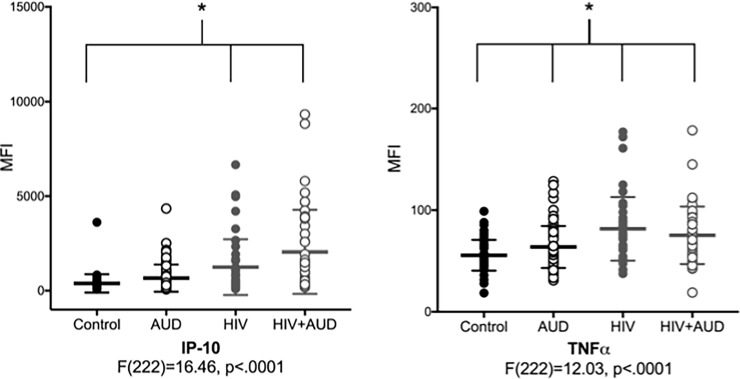
Scatter plots of the a) the chemokine Interferon γ-induced Protein 10 (IP-10) and the b) cytokine Tumor Necrosis Factor α (TNFα) in the 4 groups (Control: black closed circles; AUD: black open circles; HIV: gray closed circles; HIV+AUD: gray open circles). * indicates significance at p = .001.